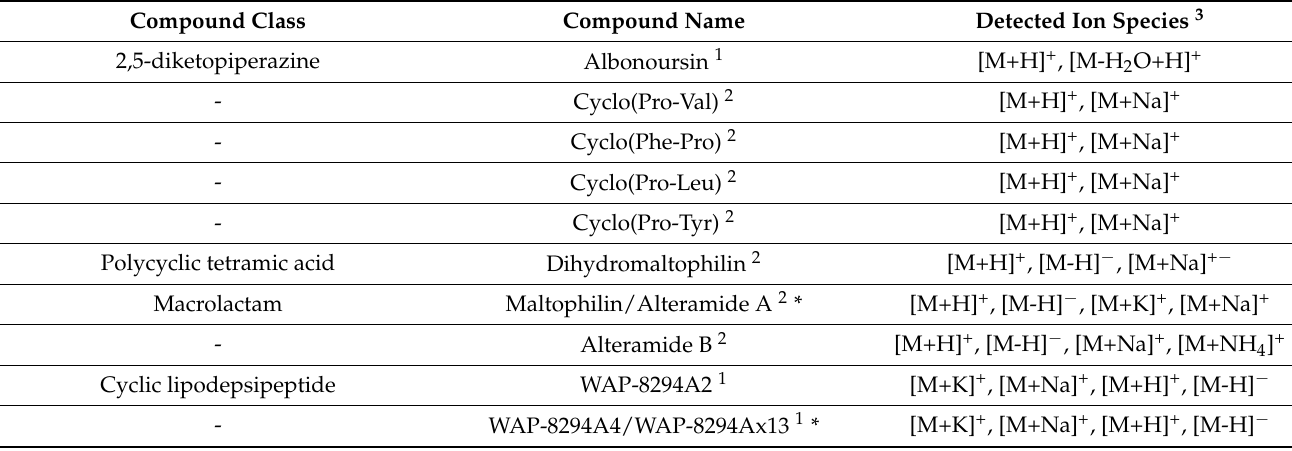
Table 2. List of the antimicrobial compounds and respective ion species found in the high-resolution mass spectra of Lysobacter capsici AZ78 (AZ78) extracts following ultra-high pressure liquid chromatography–high-resolution mass spectrometry (UHPLC-HRMS) analysis.